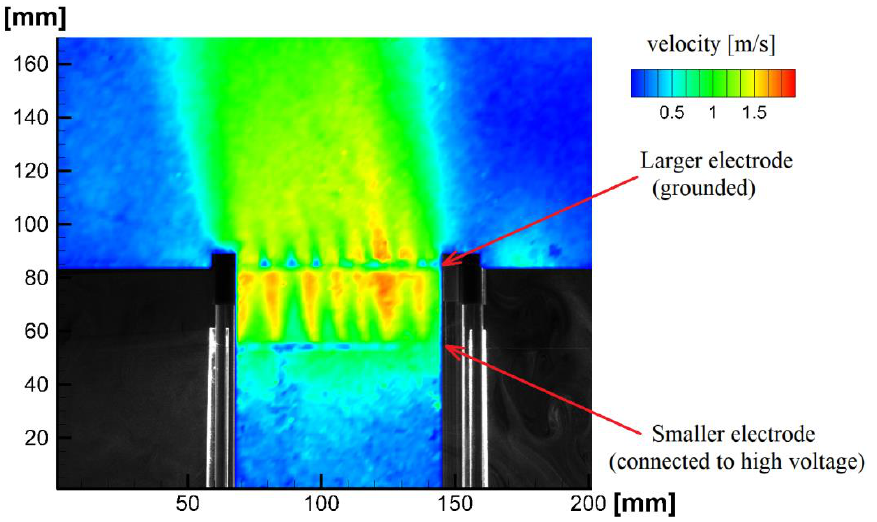
Figure 4. Scalar map of velocities obtained using PIV method examining the airflow between the electrodes for the voltage of 14